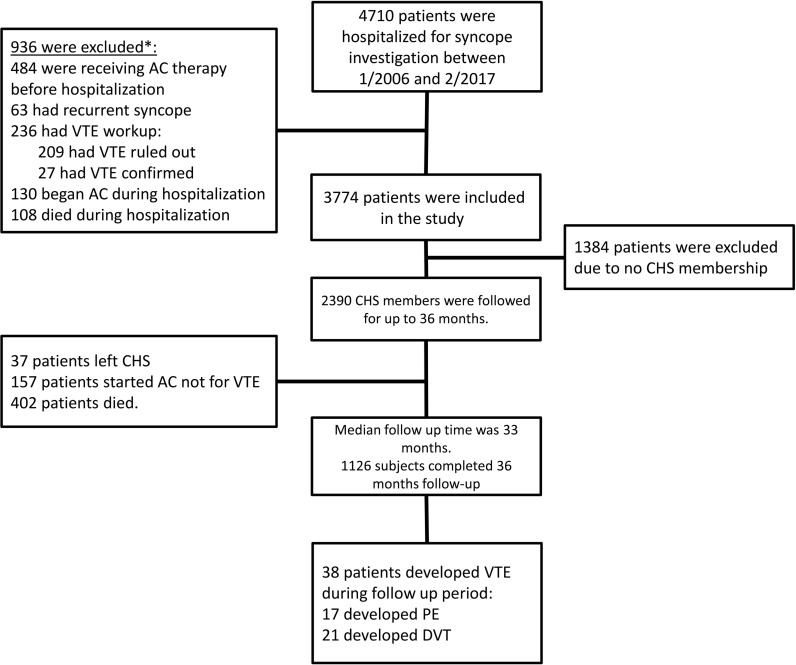
Study flow chart.* Some patients were excluded due to more than one criterion. CHS–Clalit Health Services; AC- anticoagulation; VTE- venous thromboembolism; PE- pulmonary embolism; DVT- deep vein thrombosis.